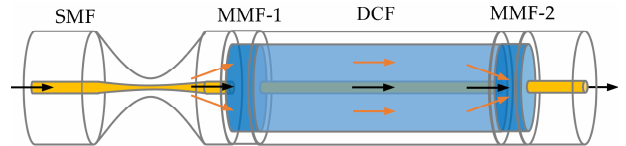
Figure 1. The schematic diagram of the single-taper and multimode-double-cladding-multimode (TMDM) with a single-pass structure.